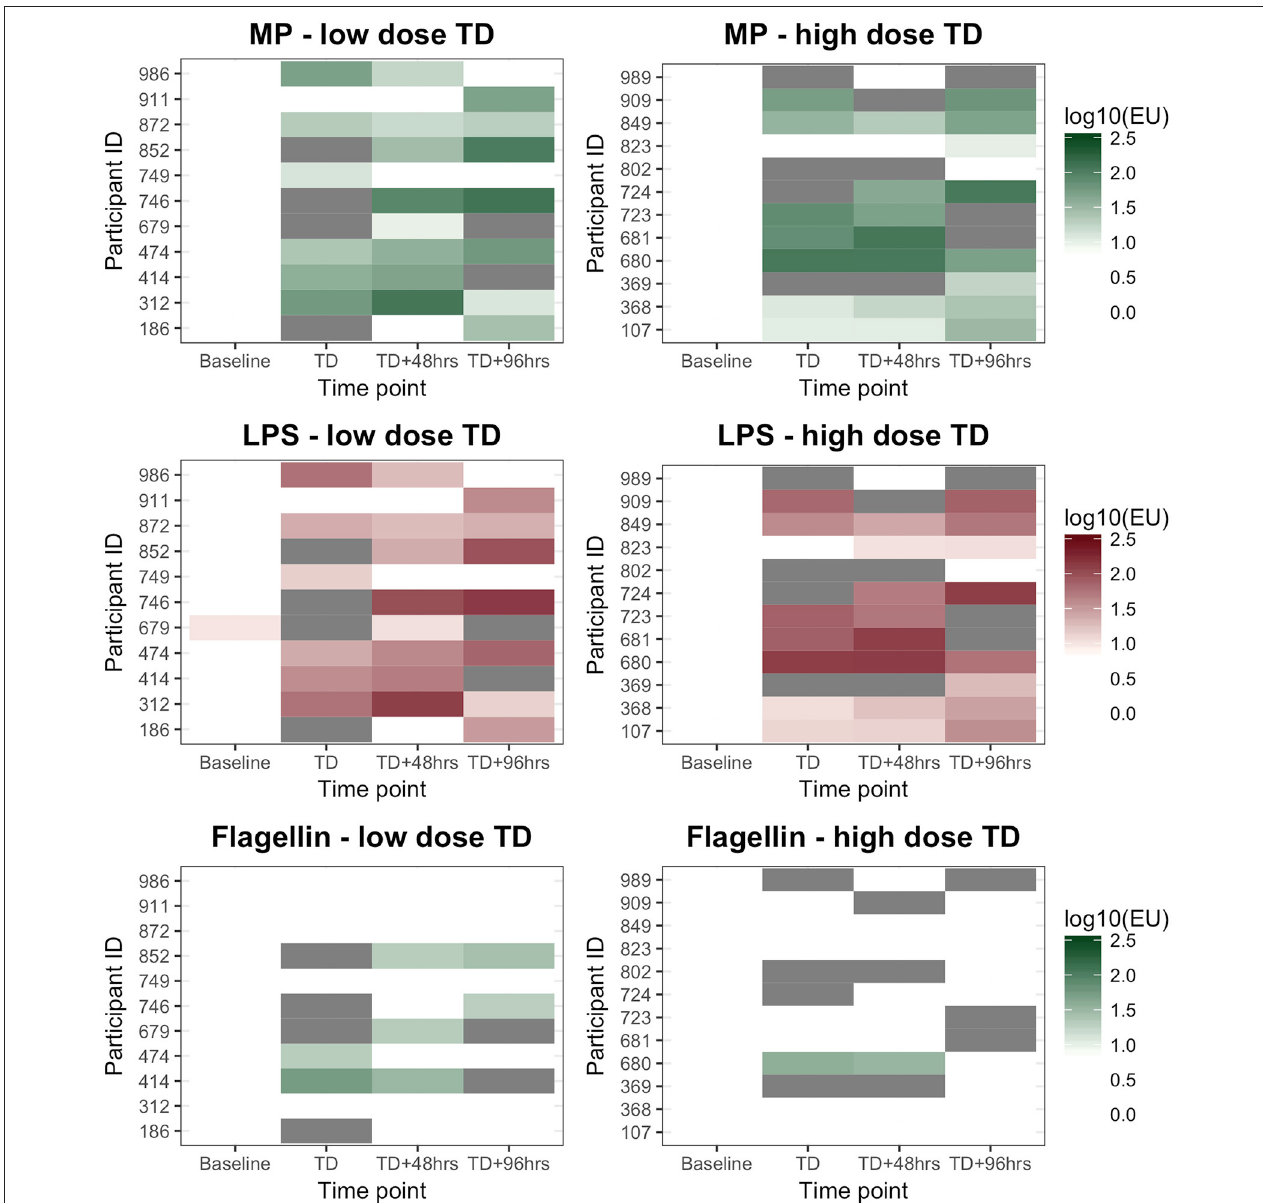
FIGURE 2 | ALS IgA diagnostic responses to MP, LPS, and flagellin in participants diagnosed with typhoid after challenge. Low dose, 1–5 × 10 3 CFU; High dose, 10–50 × 10 3 CFU. “ White ” indicates the titer was below the diagnostic cut-off (log 10 0.95, log 10 1.00, and log 10 1.28EUs for the three antigens tested, respectively). “ Gray ” indicates sample not